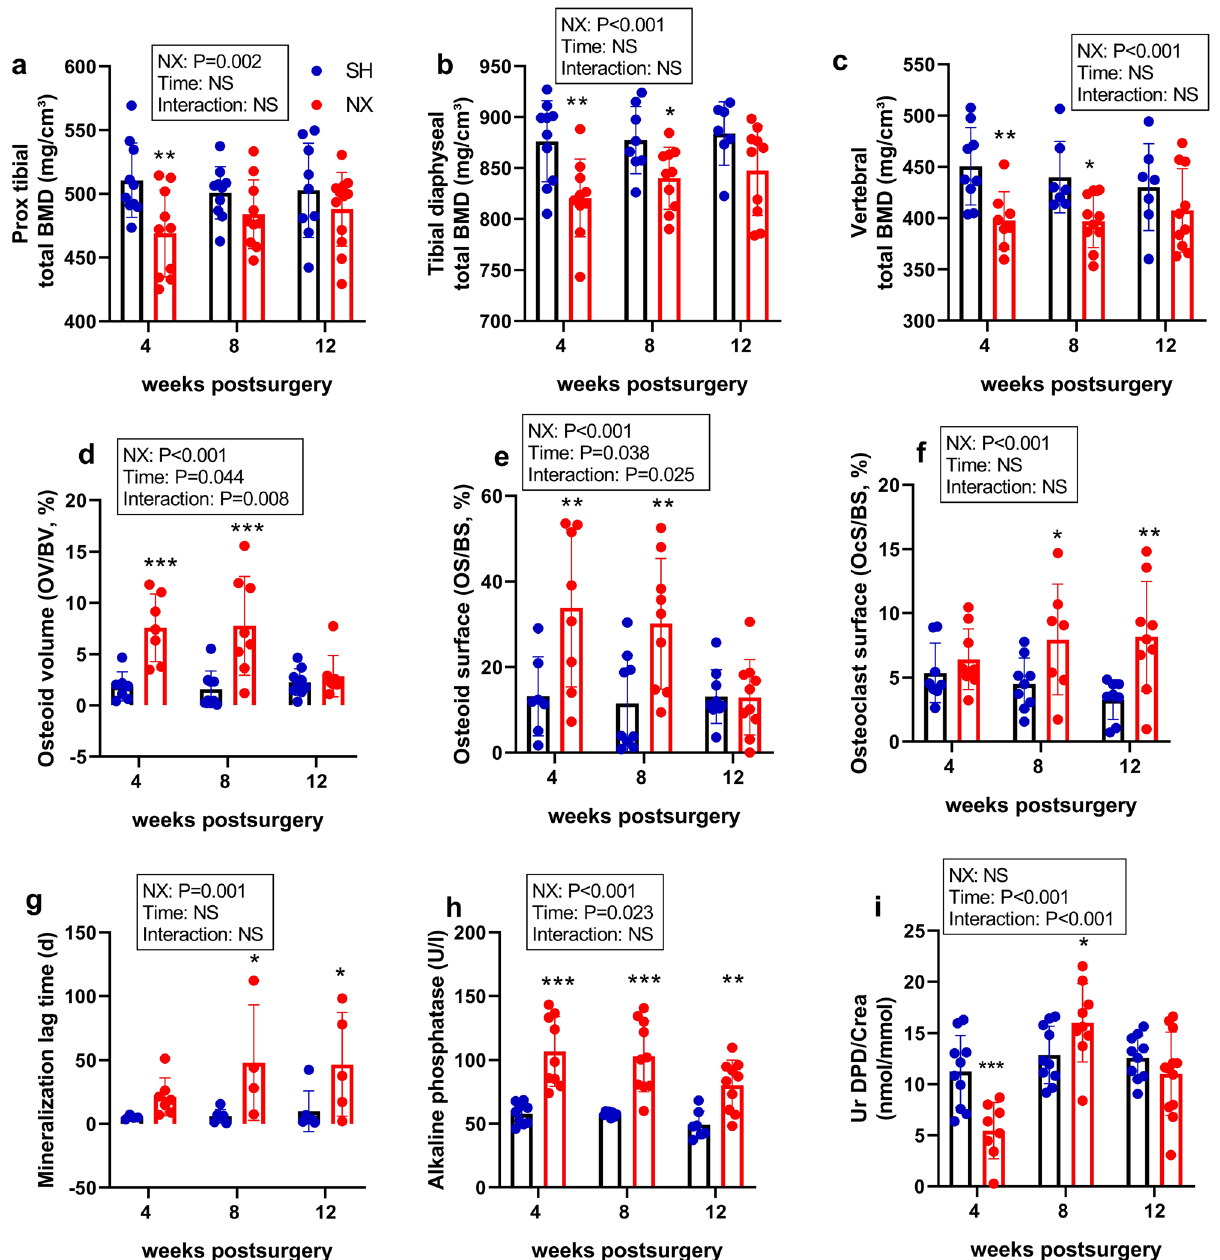
Figure 4. Reduced bone mass and impaired bone mineralization in 5/6-NX mice on CPD. ( a ) Proximal tibial total bone mineral density (BMD), ( b ) tibial diaphyseal total BMD, and ( c ) vertebral total BMD measured by pQCT; ( d ) osteoid volume, ( e ) osteoid surface, ( f ) osteoclast surface, and ( g ) mineralization lag time measured in tibial cancellous bone by histomorphometry; ( h ) serum alkaline phosphatase activity, and ( i ) urinary deoxypyridinoline/creatinine (UrDPD/Crea) excretion in Sham-operated (SH) and 5/6-Nx (NX) C57BL/6 mice on CPD, 4, 8 and 12 weeks postsurgery. N = 4–12 mice per group. Bars depict mean values ± SD. Data were analyzed using 2-way ANOVA, followed by Student’s t test. Insets show results of 2-way ANOVA. * P < 0.05; ** P < 0.01; *** P < 0.001 versus Sham at same time point by Student’s t